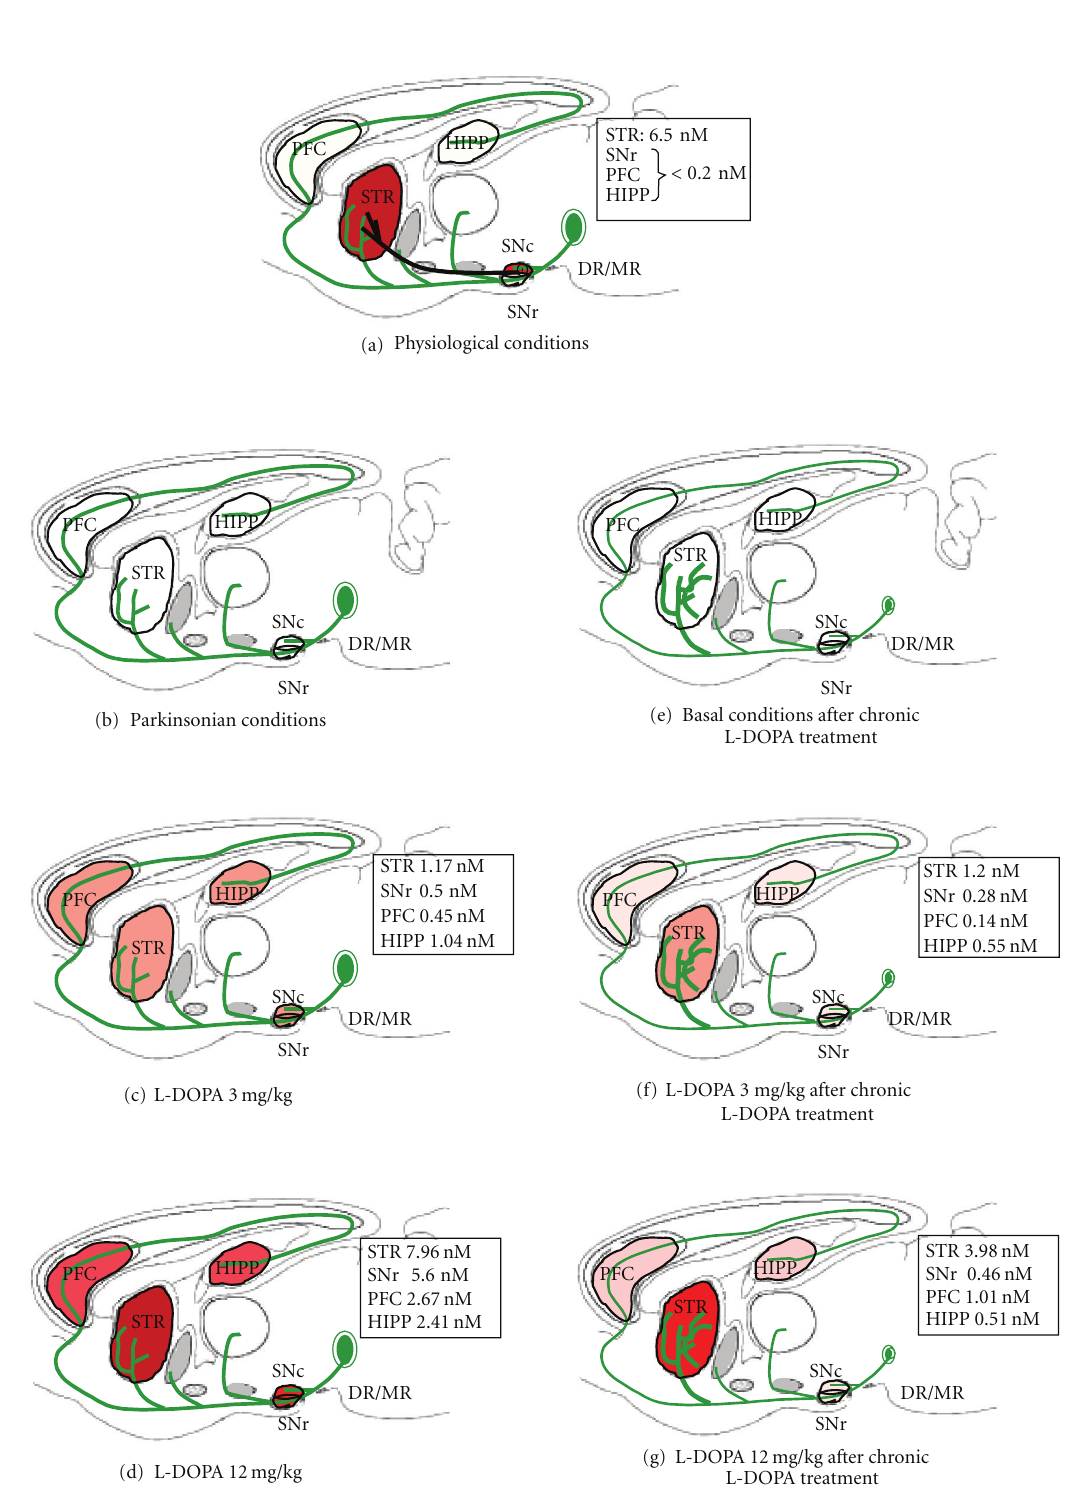
Figure 1: Serotonergic neurons are responsible for an imbalance of dopamine chemistry within brain regions in the Parkinsonian brain after acute and chronic L-DOPA treatment. Data taken from [31,